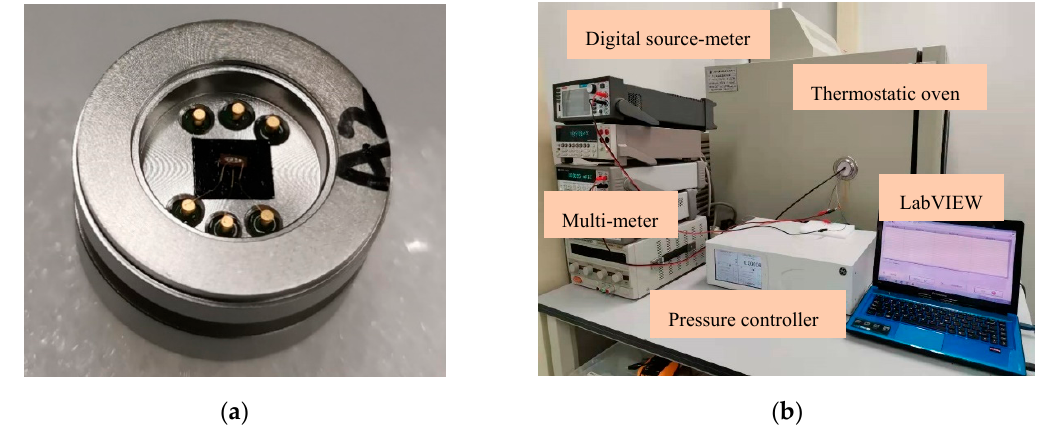
Figure 5. Photographs of calibration equipment. ( a ) Miniature pressure sensor assembled in a Kovar base. ( b ) Automatic pressure test